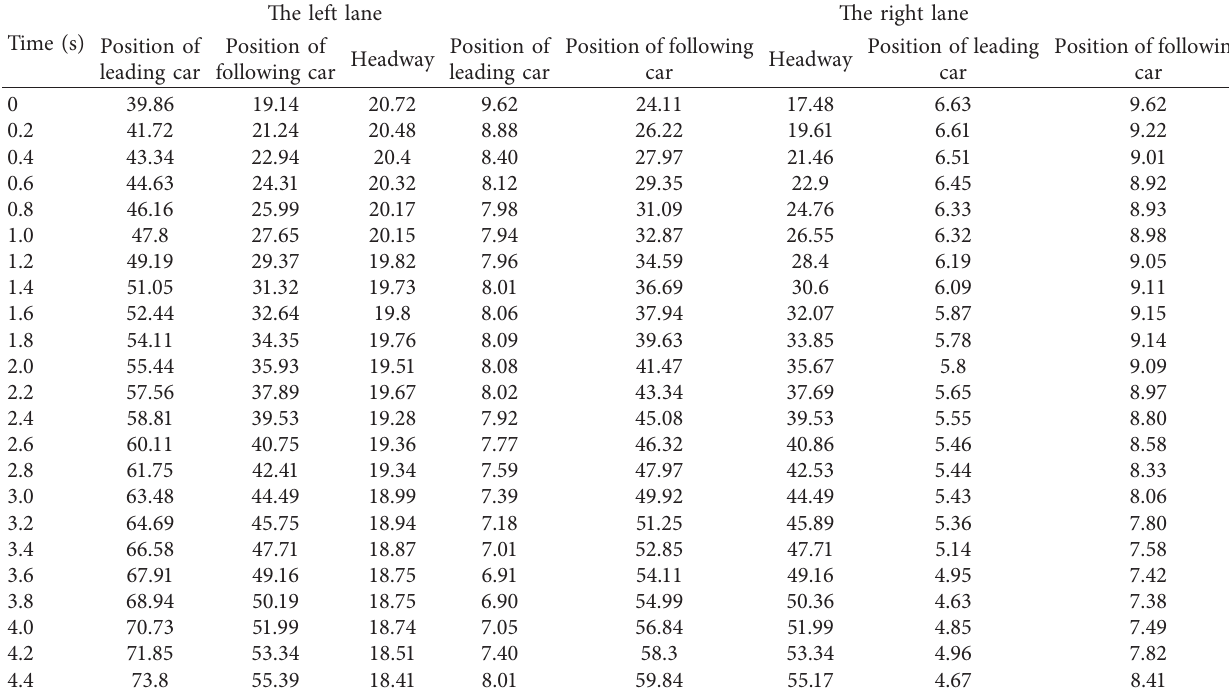
Table 4: The third sets of vehicle data.